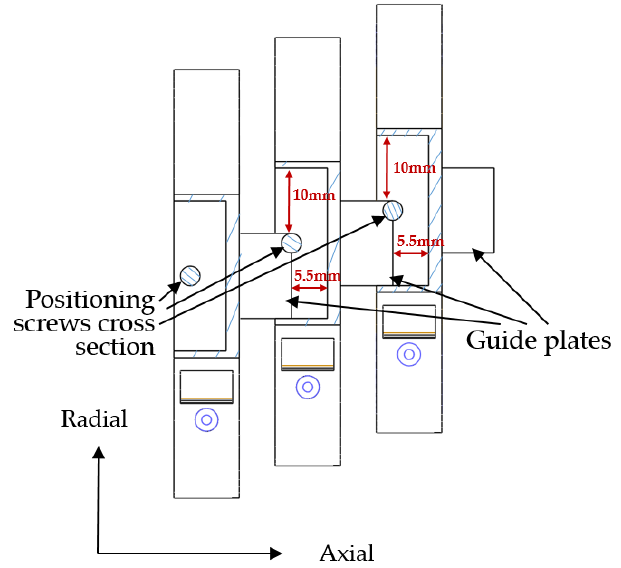
Figure 9. Directions and range of position adjustment in wristbands.